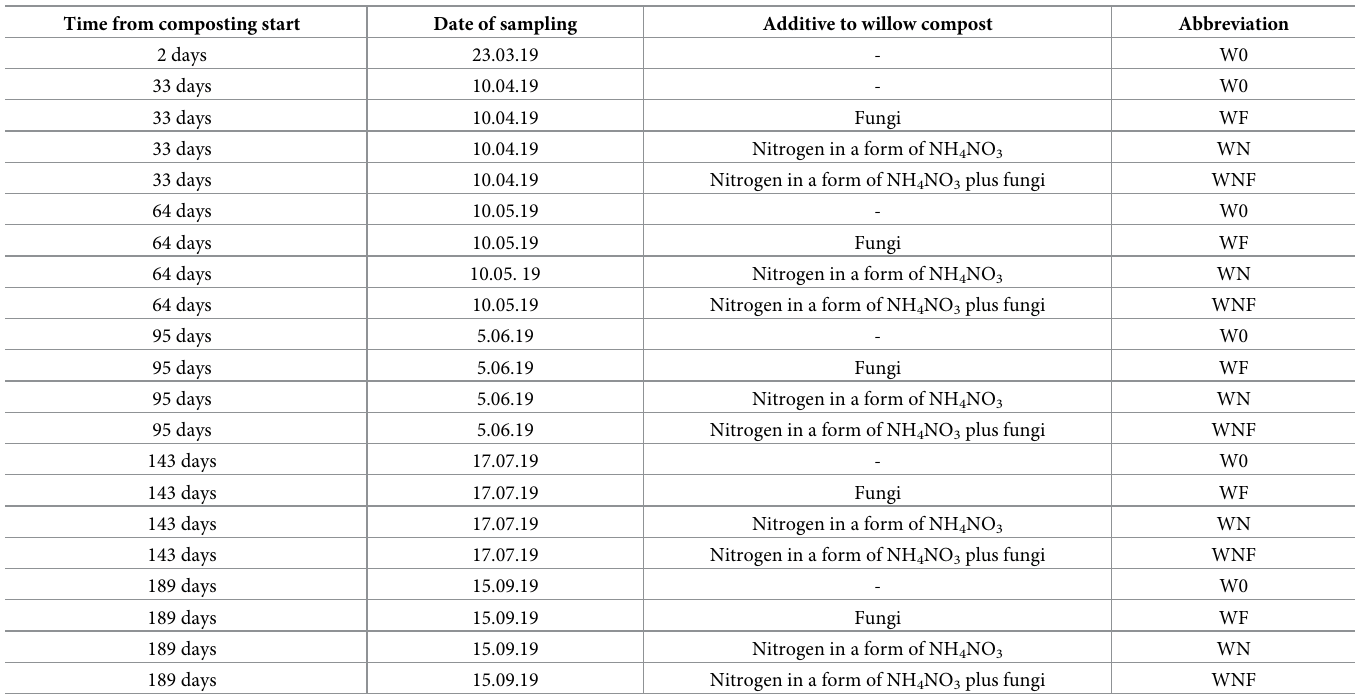
Table 1. List of sampling dates along with the duration of the composting process. Time from composting